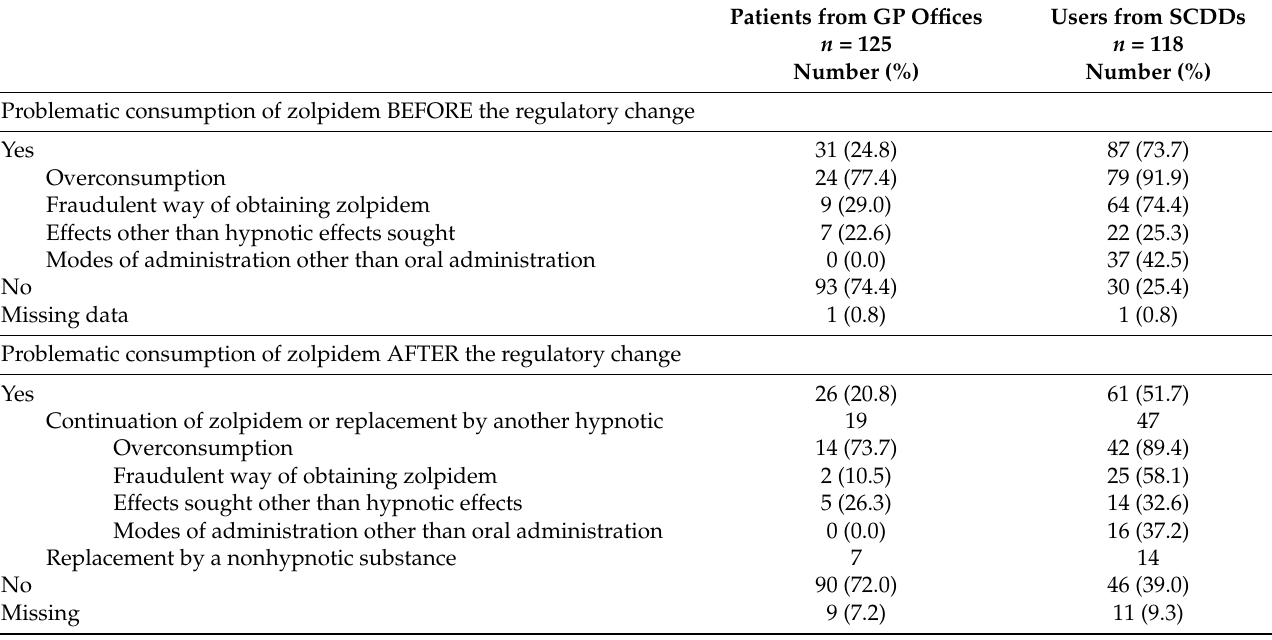
Table 2. Prevalence and criteria for problematic consumption before and after the regulatory change.